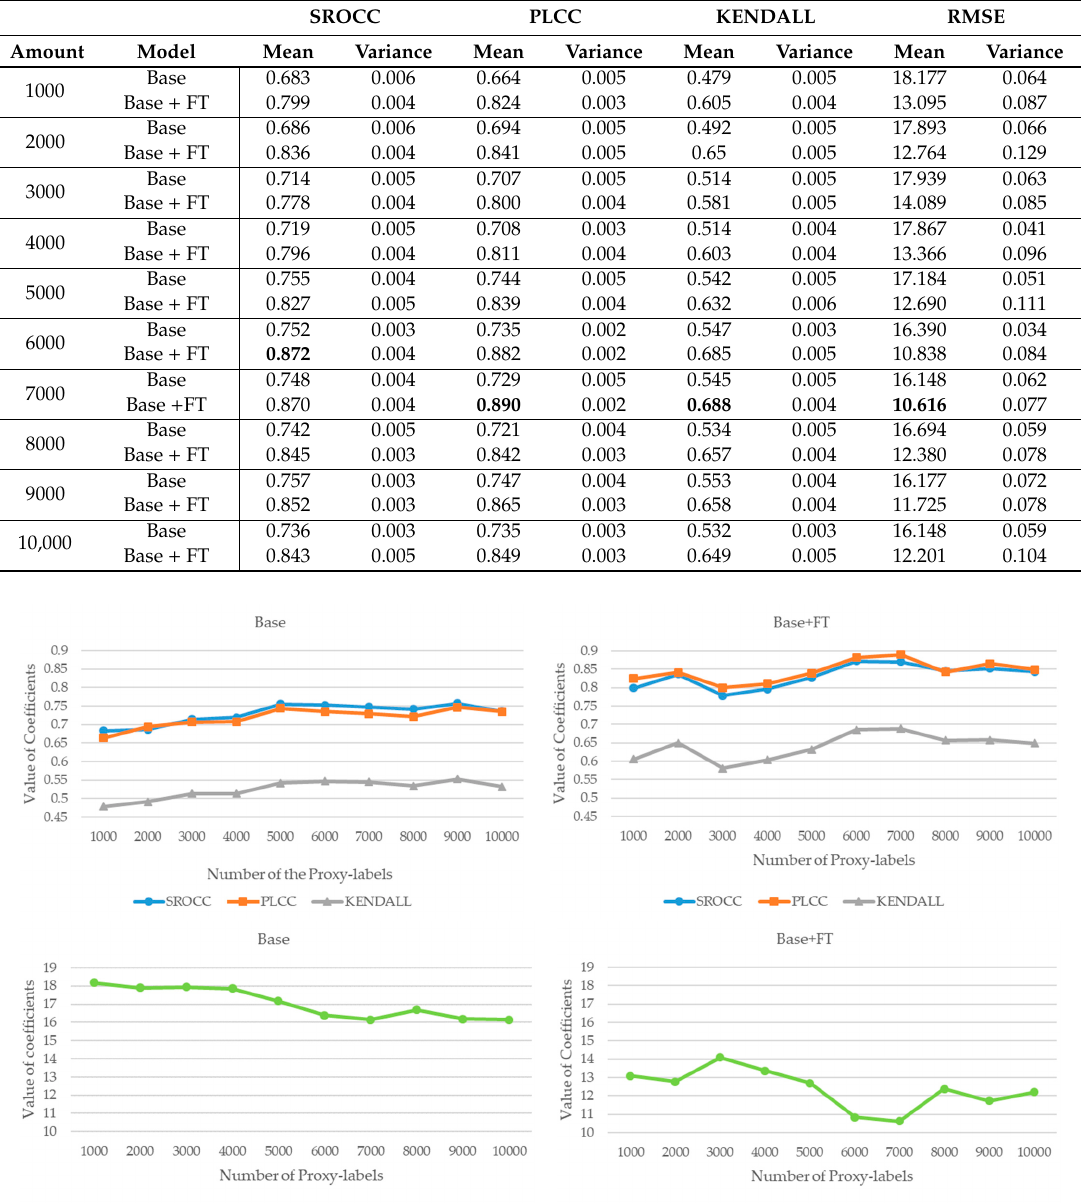
Table 3. Performance comparison between di ff erent amount of training data in the first transfer learning on LIVEC [15].